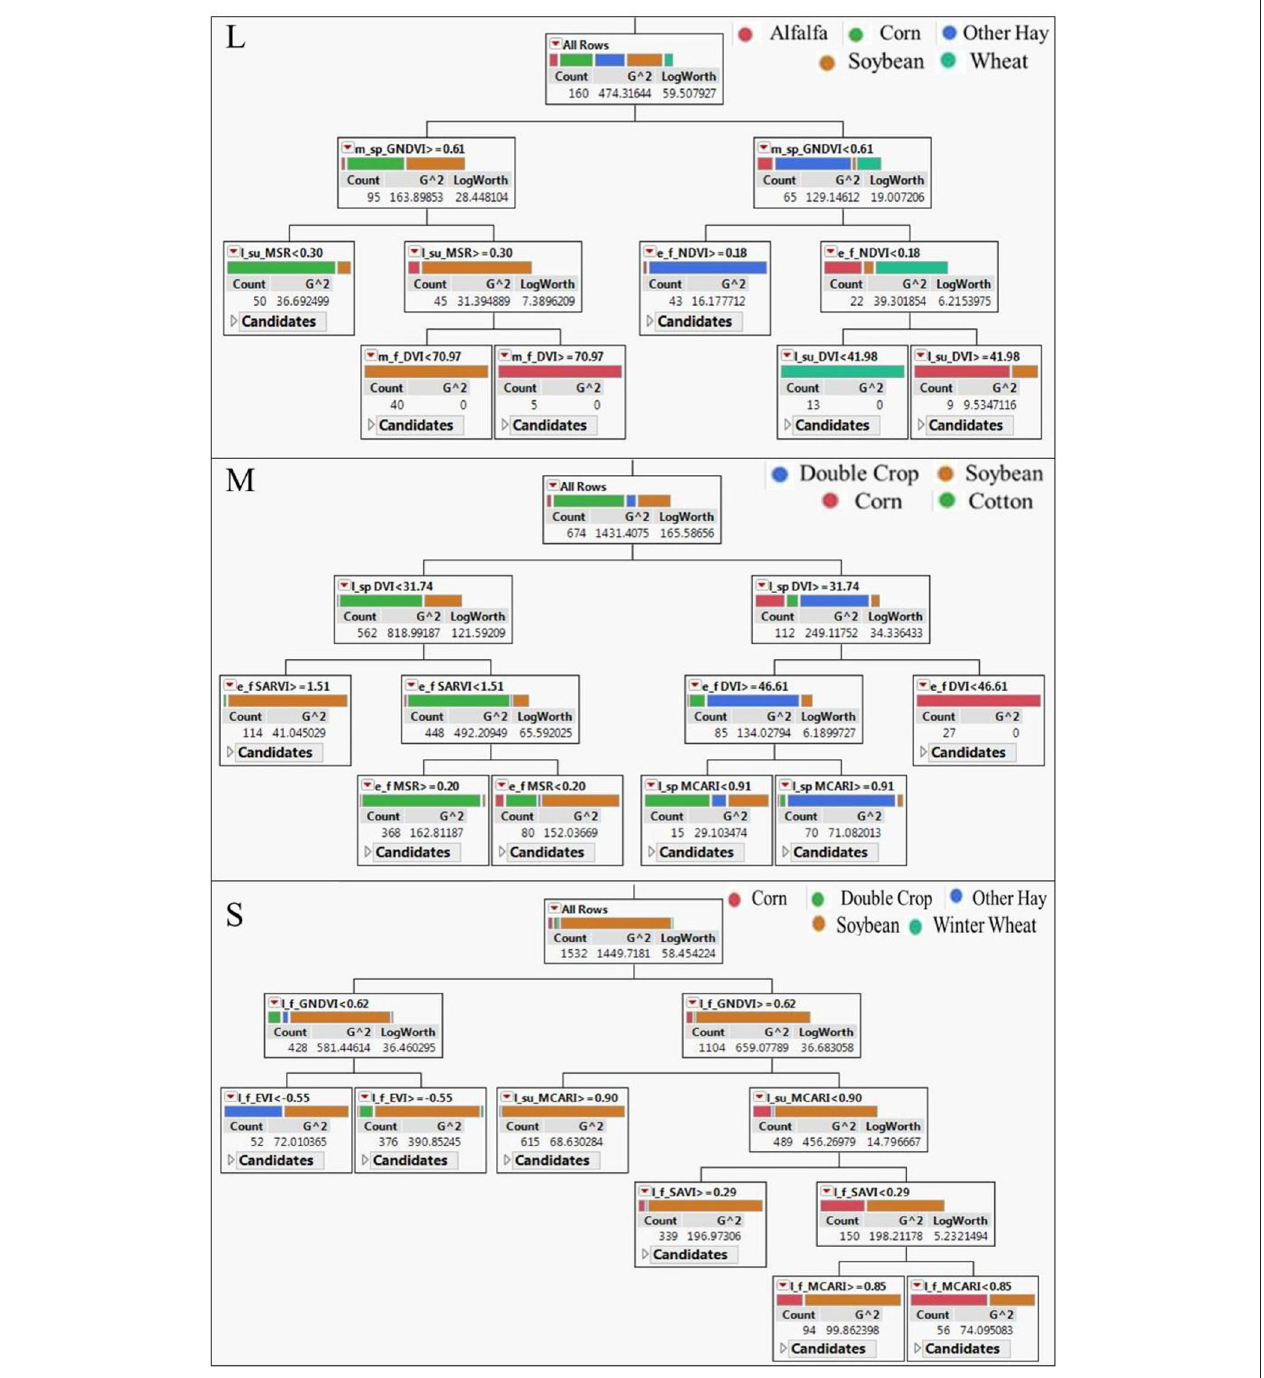
FIGURE 5 | The Decision Trees (DTs) built from the CDL 2015 reference data of the three TR regions for large (L), medium (M), and small (S) field sizes.